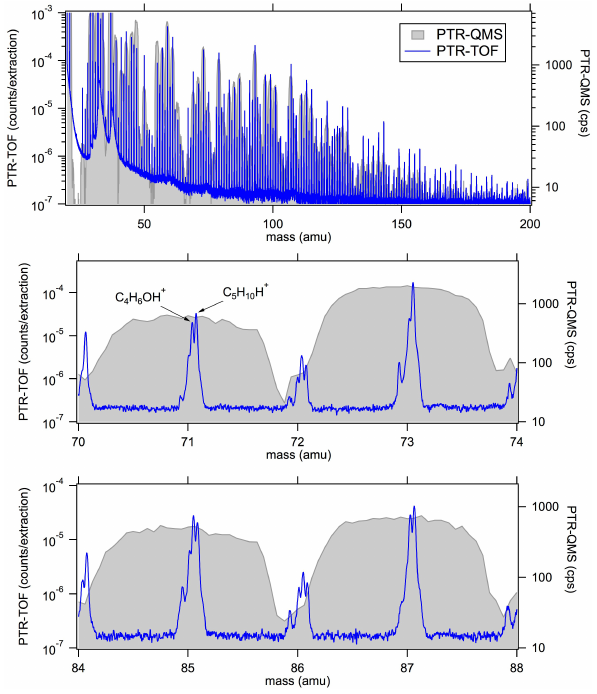
Figure 9. PTR-QMS and PTR-TOF mass scans. As an example, for m/z 71 two isobars are identified with the PTR-TOF and labeled.